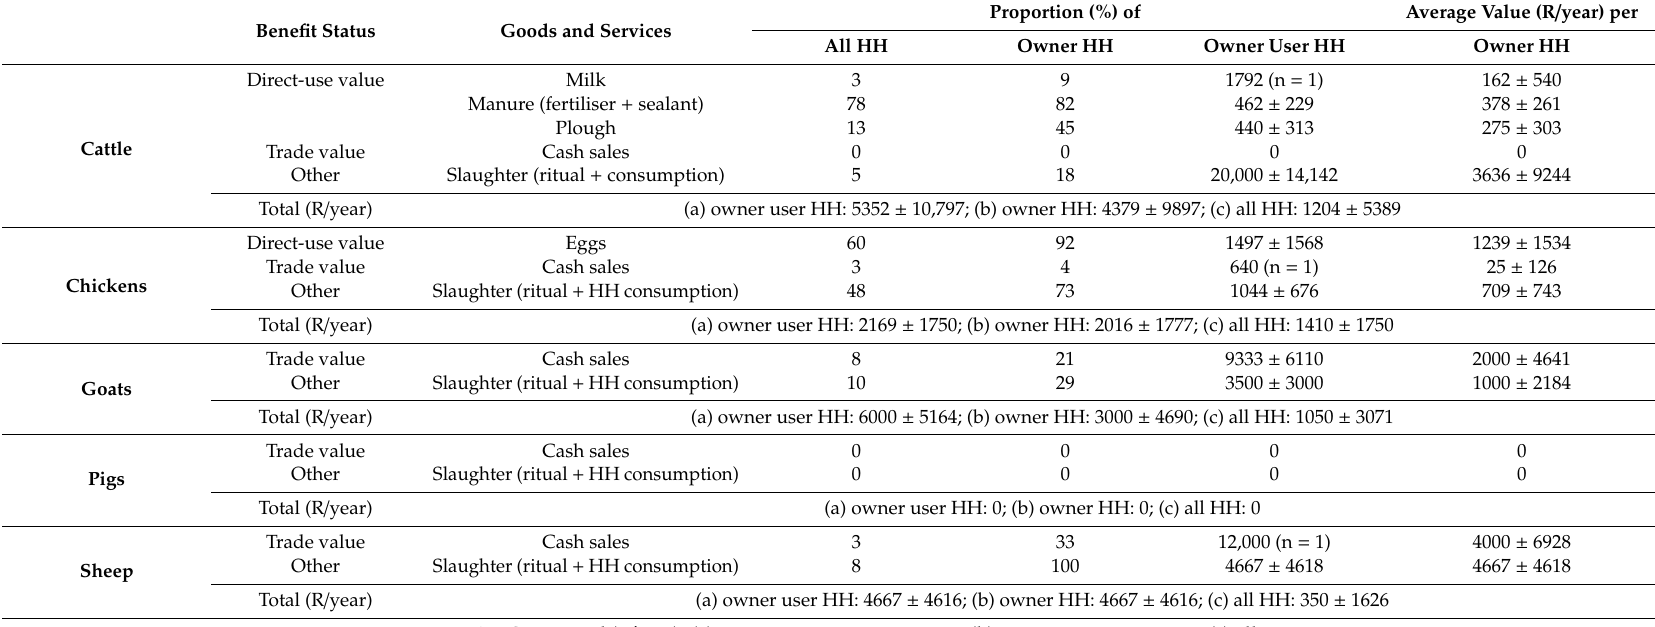
Table 4. Gross direct-use and traded values of livestock and poultry benefits to households in